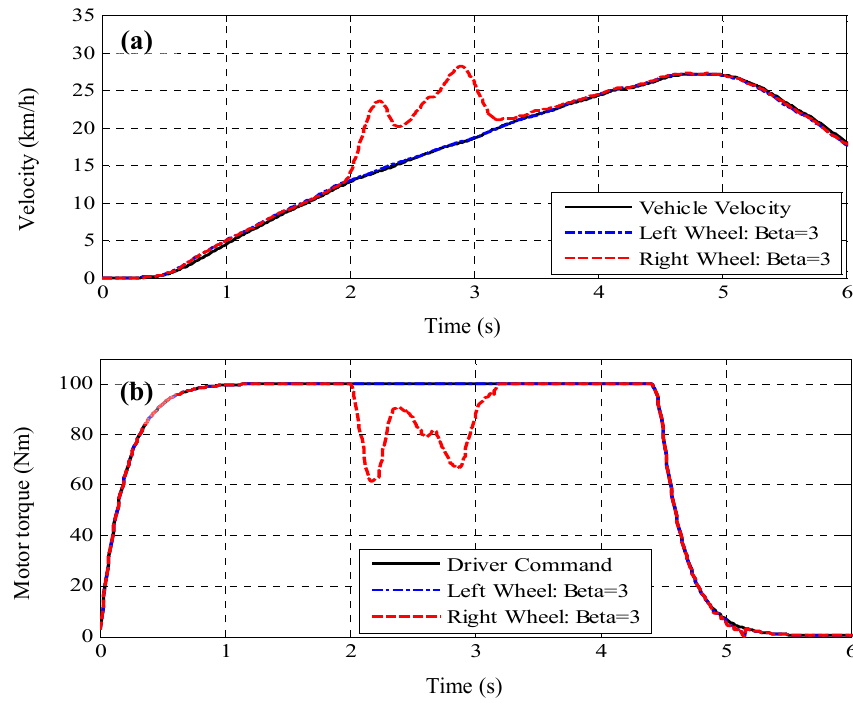
Figure 14. Experimental results with control (for 3   ): ( a ) Wheel velocity and estimated vehicle velocity; ( b ) Motor torque.